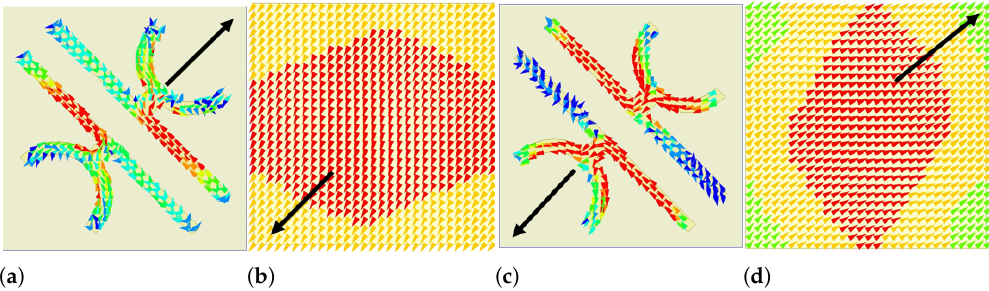
Figure 7. Surface current distribution at 0.755 THz ( a ) top metasurface ( b ) bottom ground plane, surface current at 0.94 THz ( c ) top metasurface ( d ) bottom ground